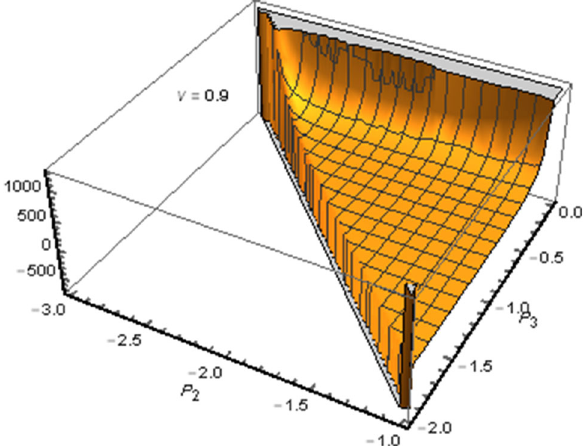
Fig. 16 This diagram indicates the behavior of shape function pre- sented in Eq. (32) for the case ν = o . 9